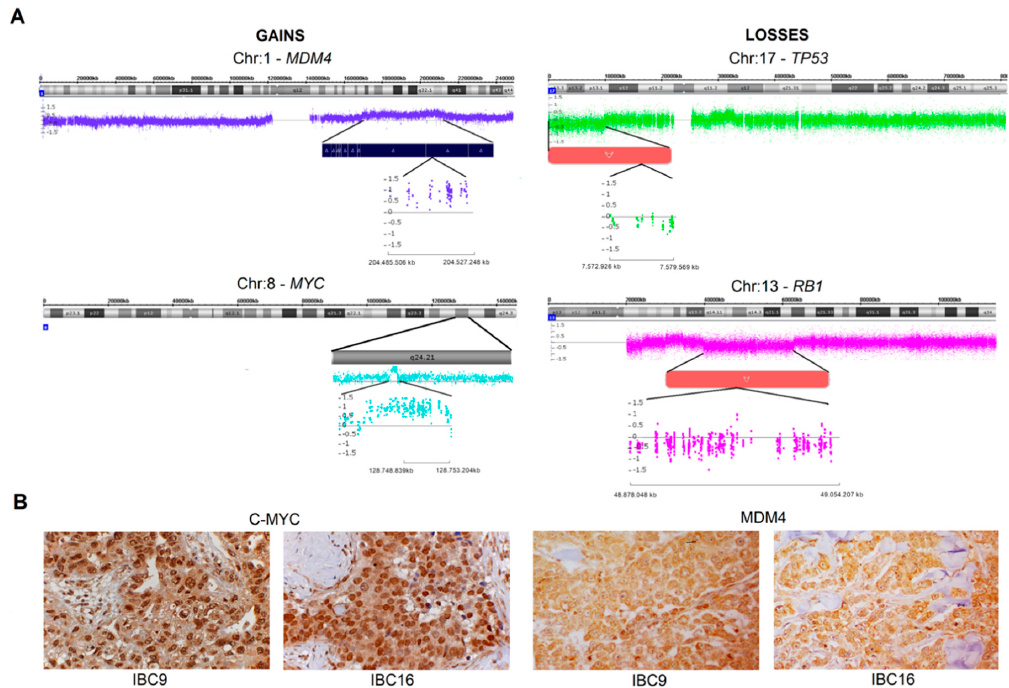
Figure 1. ( A ) Chromosomal location of some of the most common genes covered by gains (MYC and MDM4) and losses (RB1 and TP53) in inflammatory breast carcinomas. ( B ) Representative examples of high expression of C-MYC and MDM4 proteins in two cases (IBC9 and IBC16) that also showed MYC and MDM4 gains in the microarray analysis. It is possible to observe di ff use C-MYC and